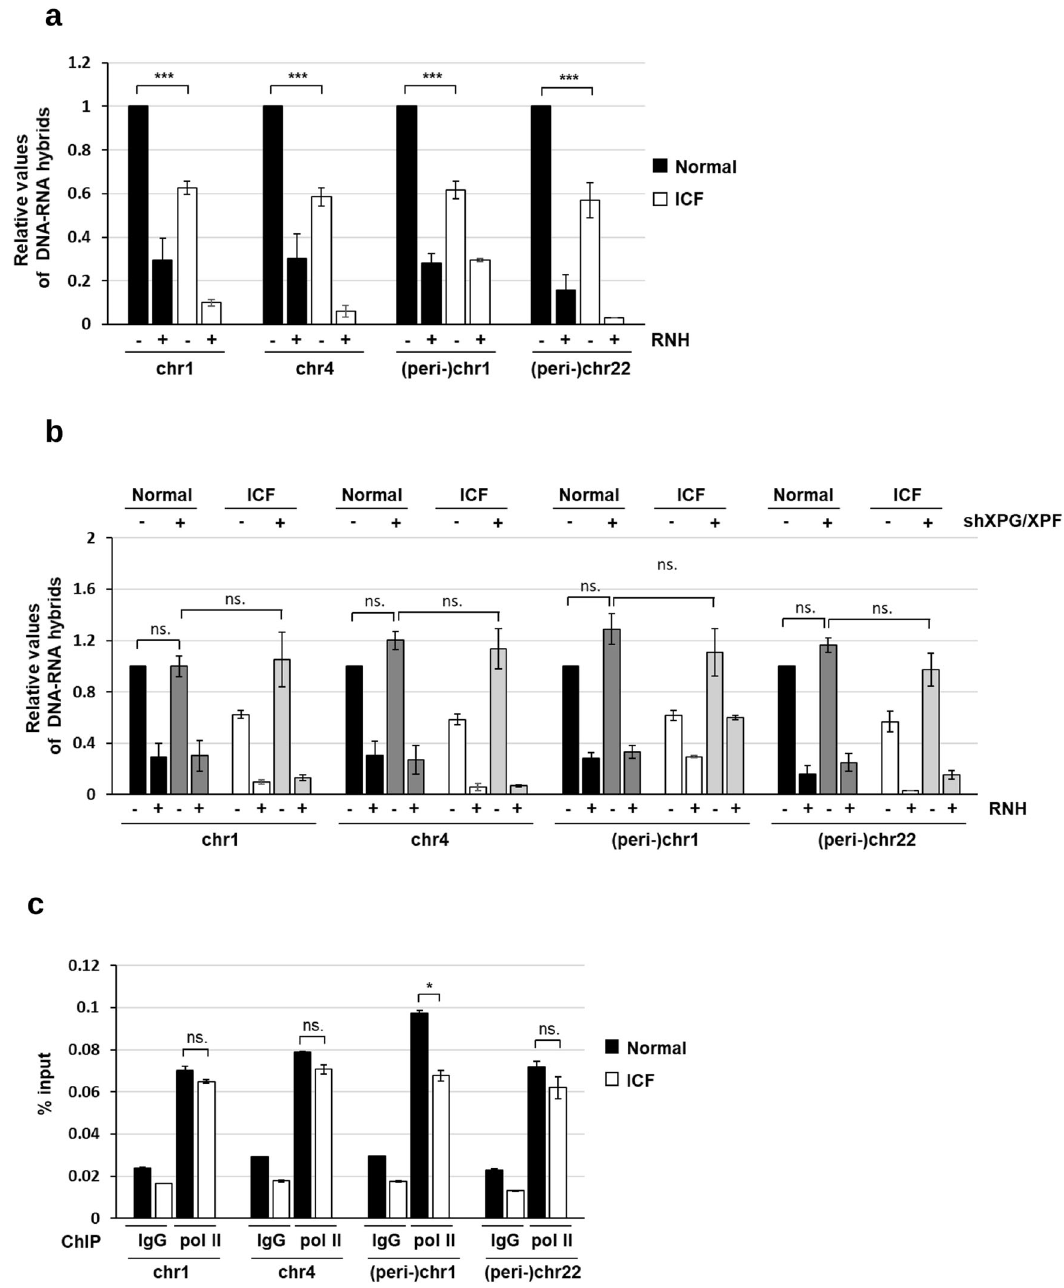
Fig. 6 The functional mutation of DNMT3b in ICF increases XPG/XPF accessibility to (peri-)centromeric R-loops. a , b Levels of (peri-) centromeric R-loops by DRIP analysis. a Wild-type and ICF LCL cells. b Cells with or without XPG/XPF knockdown. All DNA samples were untreated ( – ) or treated ( + ) with RNase H followed by S.9.6 antibody immunoprecipitation for qPCR analysis at (peri-)centromere sequences of chromosomes. qPCR values of DNA-RNA hybrids are normalized by IgG control. Data are expressed relative to that in wild type cells and presented as mean ± SEM of three independent experiments (*, ** P < 0.05, 0.01, ns: no signi fi cant by two-tailed unpaired Student ’ s t -test, RNH: RNase H). c Pol II-ChIP-qPCR analysis in wild-type and ICF LCLs. Data are shown as % of input DNA in Pol II antibody versus IgG control at